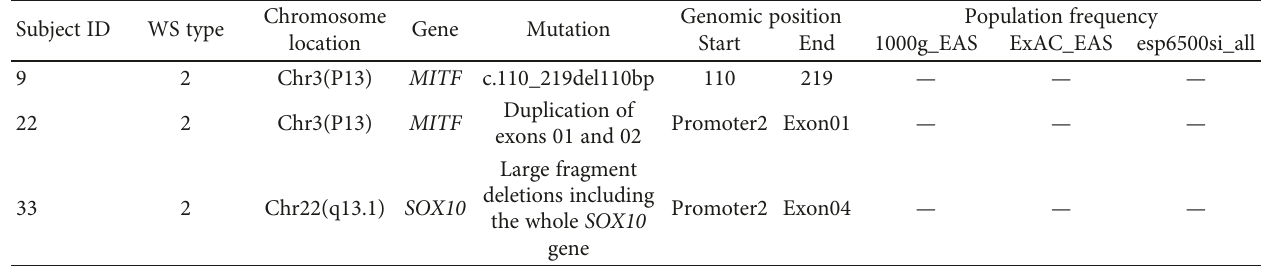
Table 4: Summary of new structure variation (SV) or CNV-detected results of the molecular screening of WS-related genes, including location of mutations and population